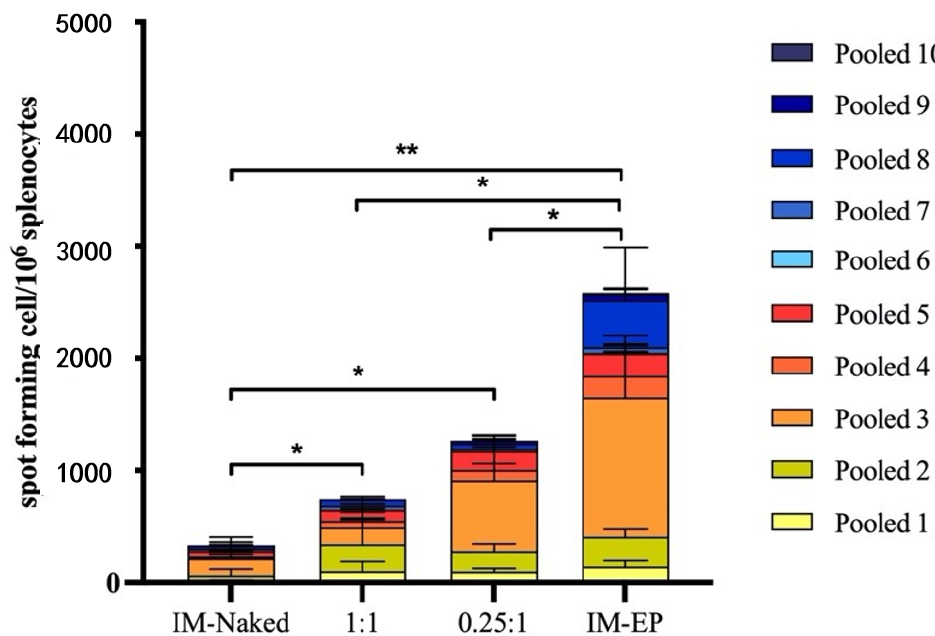
Figure 11. SARS-CoV-2 spike-specific T cell responses analyzed by ELISpot. Mouse splenocytes were stimulated with pooled peptides from S1 (pool 1–5) and S2 (pool 6–10) regions. Each bar represents sum of IFN- γ responses in mice ( n = 5) immunized with different immunization strategies including naked pCMVkan-S (IM-naked), pCMVkan-S formulated with DOTAP4 at N/P ratios of 1:1 and 0.25:1, and by using electroporator device (IM-EP). * and ** indicate p < 0.05 and p < 0.01,